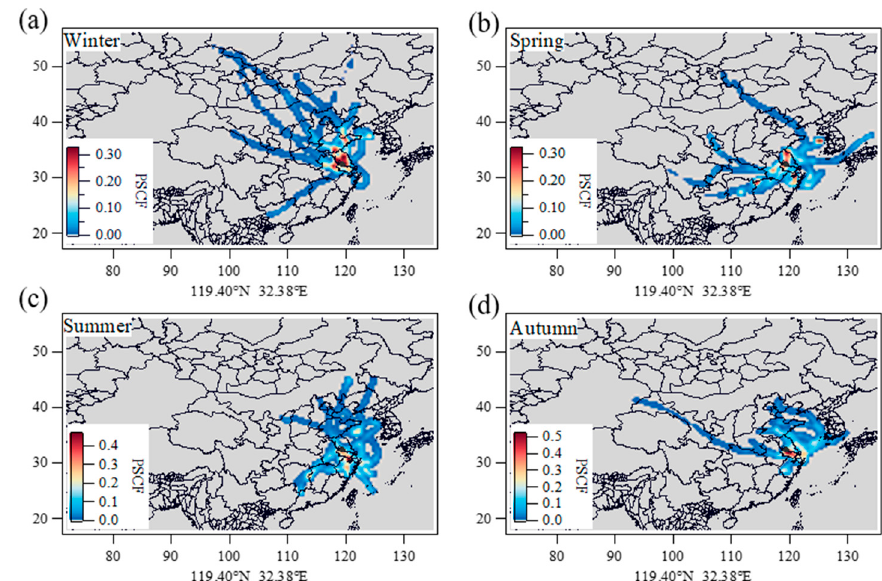
Figure 10. The potential source contributions to WSON during ( a ) winter, ( b ) spring, ( c ) summer, and ( d ) autumn (colored by the potential source contribution function (PSCF) values).